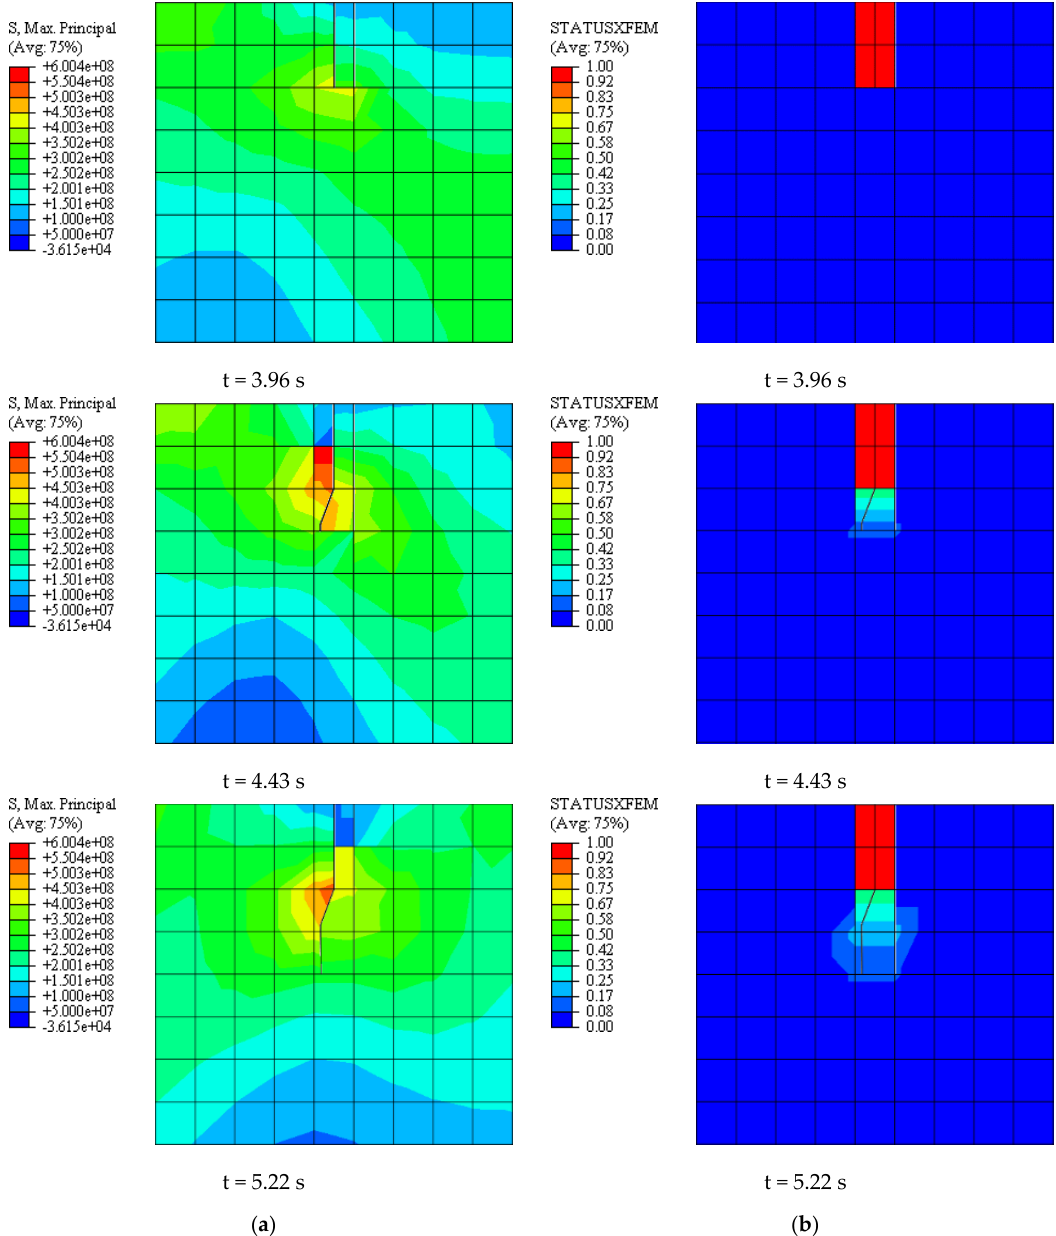
Figure 21. Crack propagation paths at different transient times ( d = 2 mm, Q = 10 kJ/cm): ( a ) maximum principal stress (MPS) contours; ( b ) status of the enriched element (STATUSXFEM).